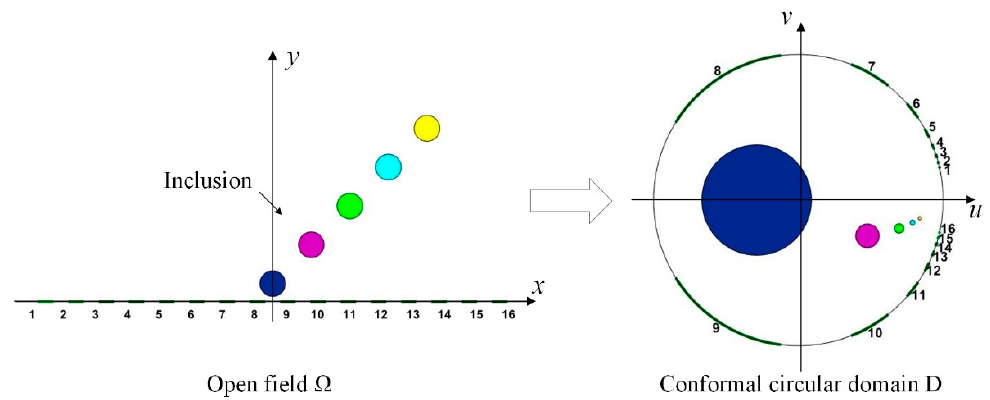
Figure 2. Mapping of inclusions and electrode positions after conformal transformation based on conventional sensor structure.